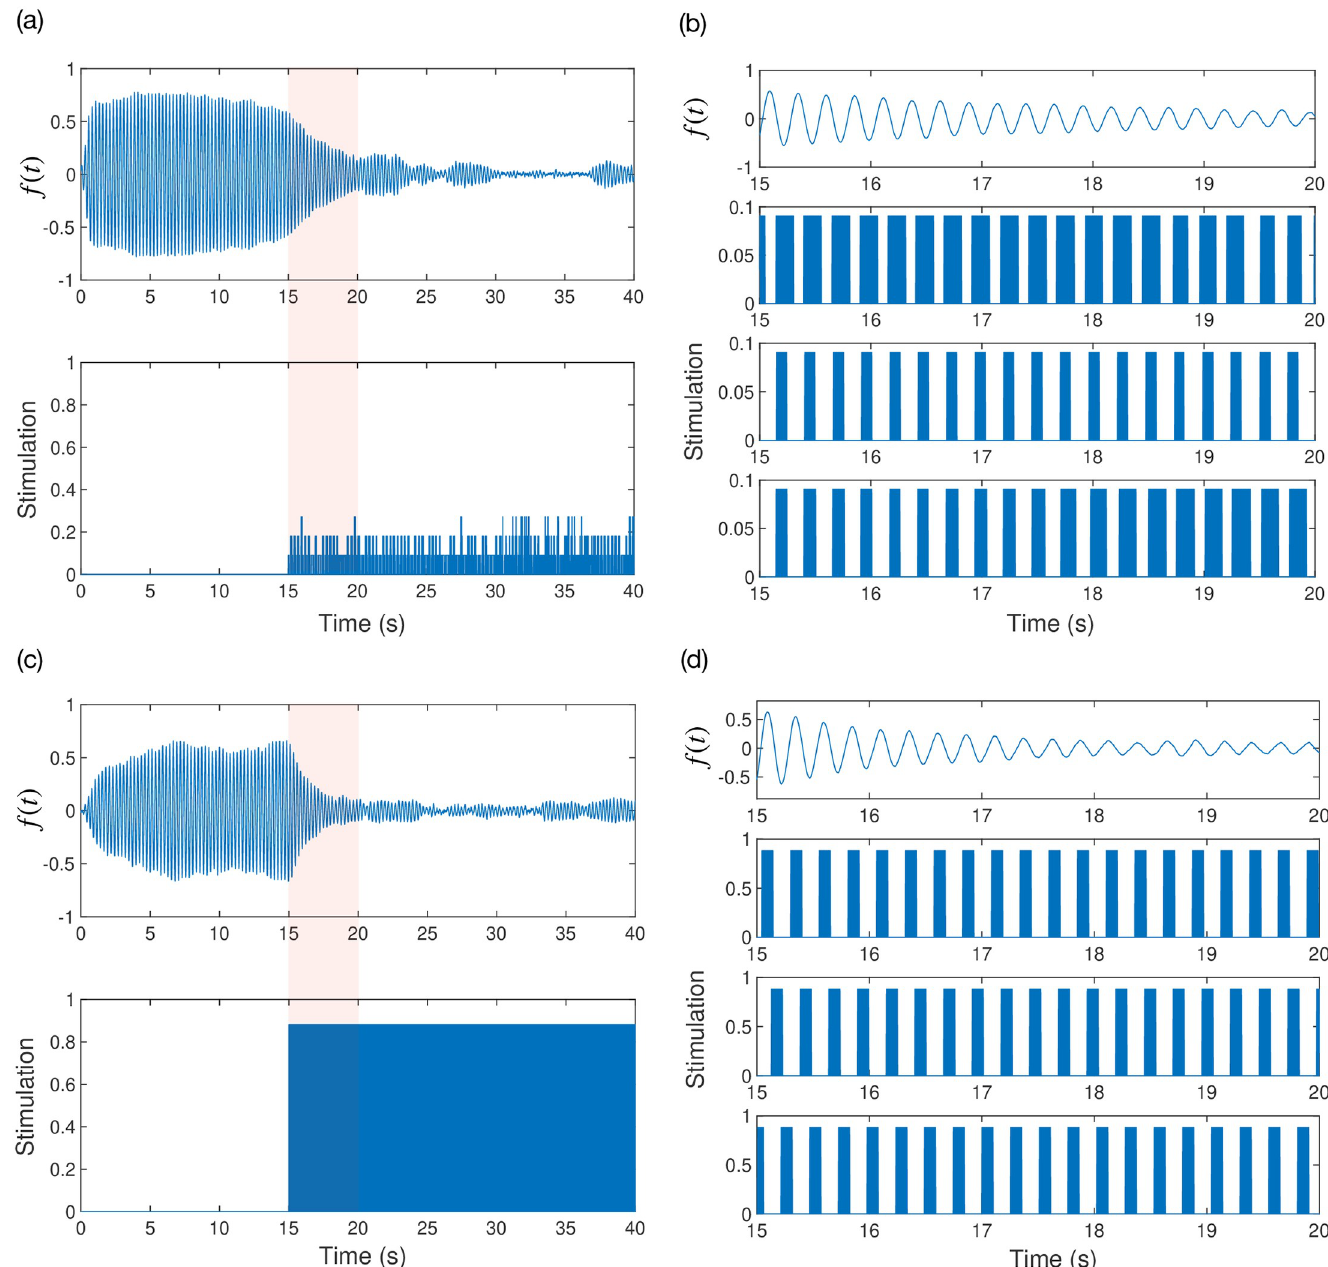
Fig 6. Output from numerical simulations showing the effects of adaptive coordinated desynchronisation (ACD) and coordinated reset (CR). The top panels (a)- (b) show the model output for ACD and the bottom panels (c)-(d) show the model output for CR. The left column shows model output together with the stimulation (averaged across contacts) as a function of time. The right column shows model output and stimulation for each contact for the respective shaded segment of the left column. The shaded portion of the stimulation for the left column is simply the average across contacts of the stimulation shown in the right column.